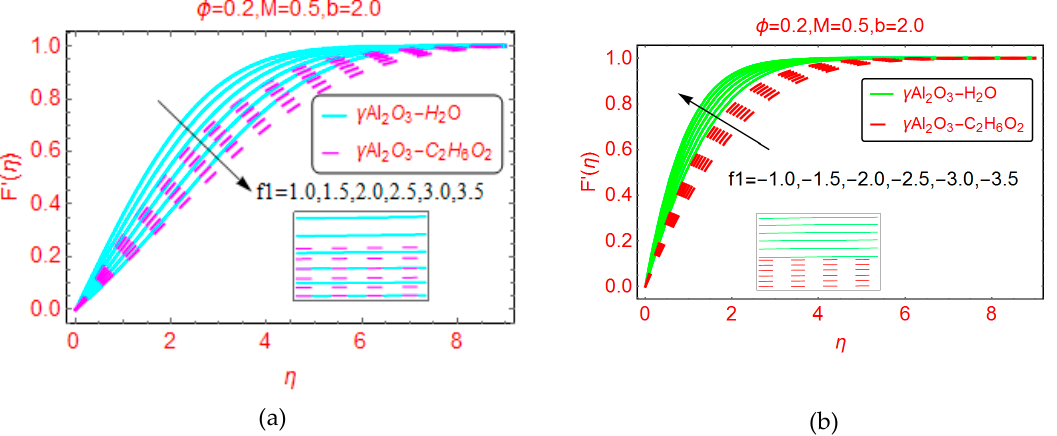
Figure 3 . Effects of permeable parameter on the velocity 𝐹′(𝜂) for ( a ) positive 𝑓1 and ( b ) negative 𝑓1 Please add the following sentence for Figure 16 in the main text.